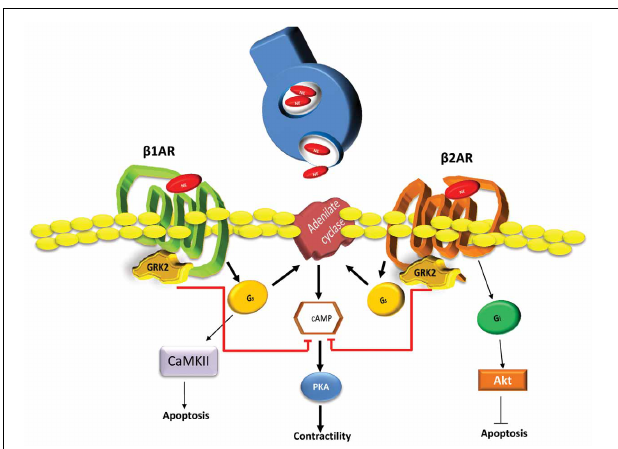
FIGURE 1 | Differential signaling pathways activated by β 1 ARs and β 2 ARs in cardiomyocytes. Following SNS catecholamines (Norepinephrine-NE) stimulation, activated β 1 ARs and β 2 ARs induce the production of cAMP through Gs activation of adenylyl cyclase (AC). Next, cAMP activates PKA resulting in positive chronotropic and inotropic